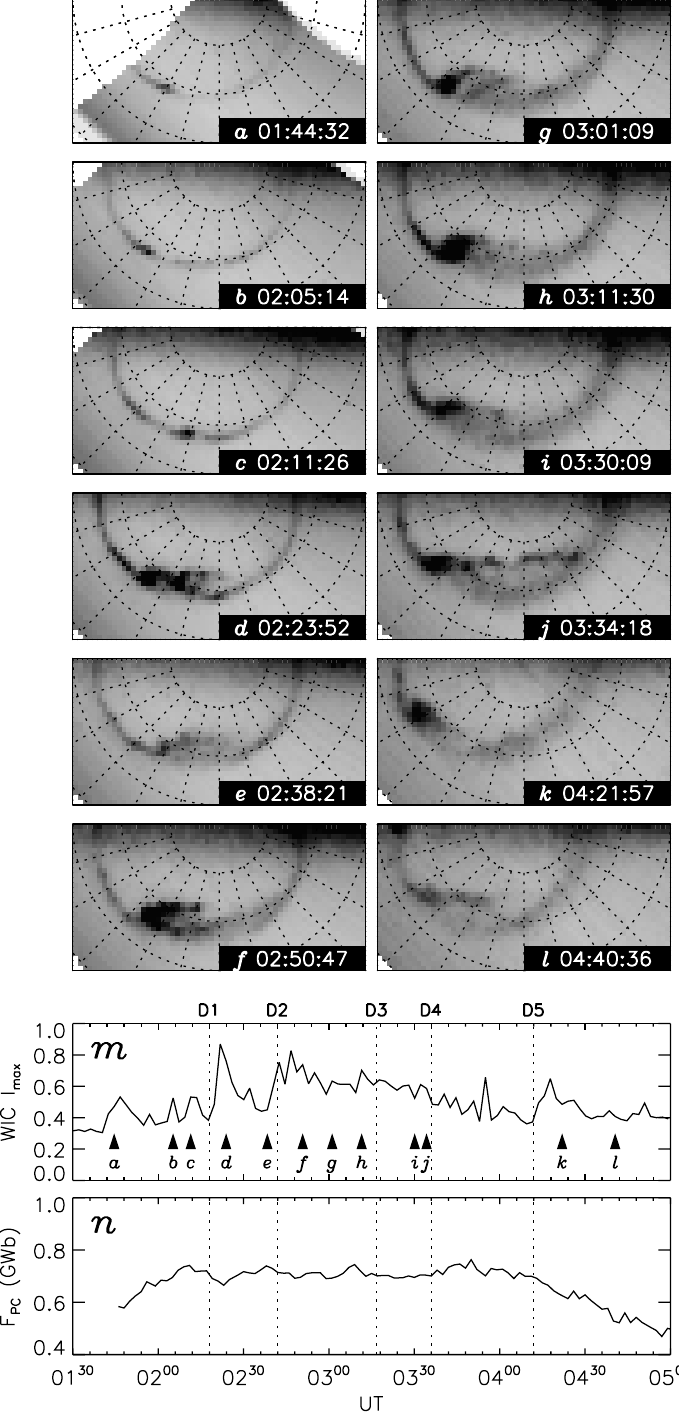
Fig. 6. (a)–(l) Selected snapshots of the nightside auroral configuration taken by the FUV/WIC camera onboard IMAGE, presented in a magnetic latitude and local time frame. Latitudes indicated are 60 ◦ , 70 ◦ , and 80 ◦ ; local time ranges clockwise from 18:00 MLT, through 00:00 MLT to 06:00 MLT. Darker grey indicates brighter aurora. (m) The maximum auroral brightness (on an arbitrary scale) observed in the local time range 20:00–04:00 MLT and between latitudes of 65 ◦ and 80 ◦ . (n) An approximate estimate of the open flux content of the magnetosphere F PC , derived by integrating the magnetic flux through the dim portion of the ionosphere inside the auroral